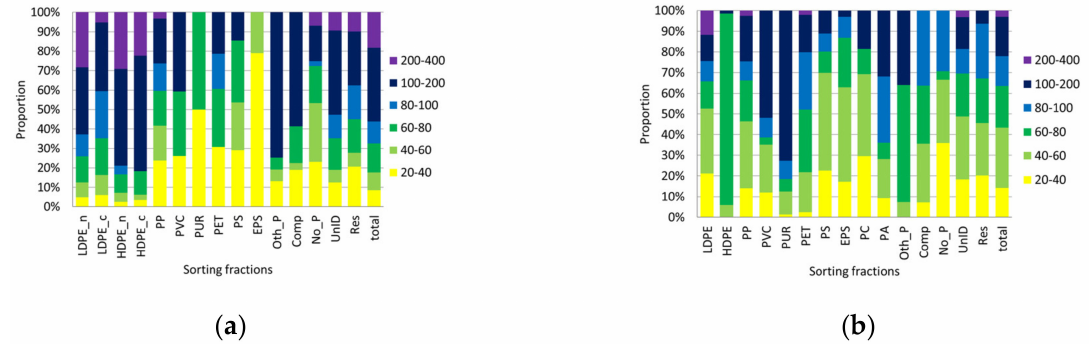
Figure 10. Particle size distribution in investigated material types for plastics-2D ( a ) and plastics-3D ( b ) normalized to 100% for mixed commercial waste